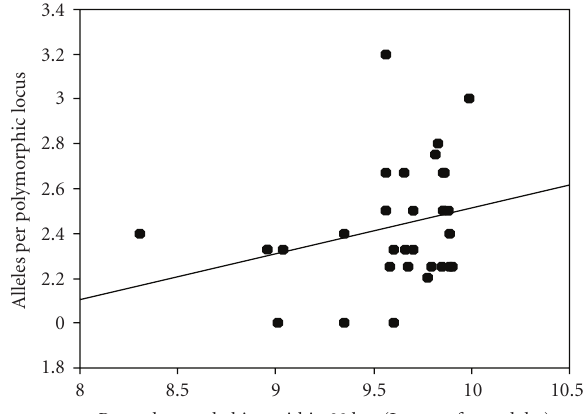
Figure 4: Alleles per polymorphic locus as a function of the amount of presettlement habitat remaining within 32 km (ha, Ln scale), for Liatris ohlingerae. r = 0.264, P = . 158. When used in multiple regression, this relationship was significant (Table 1).